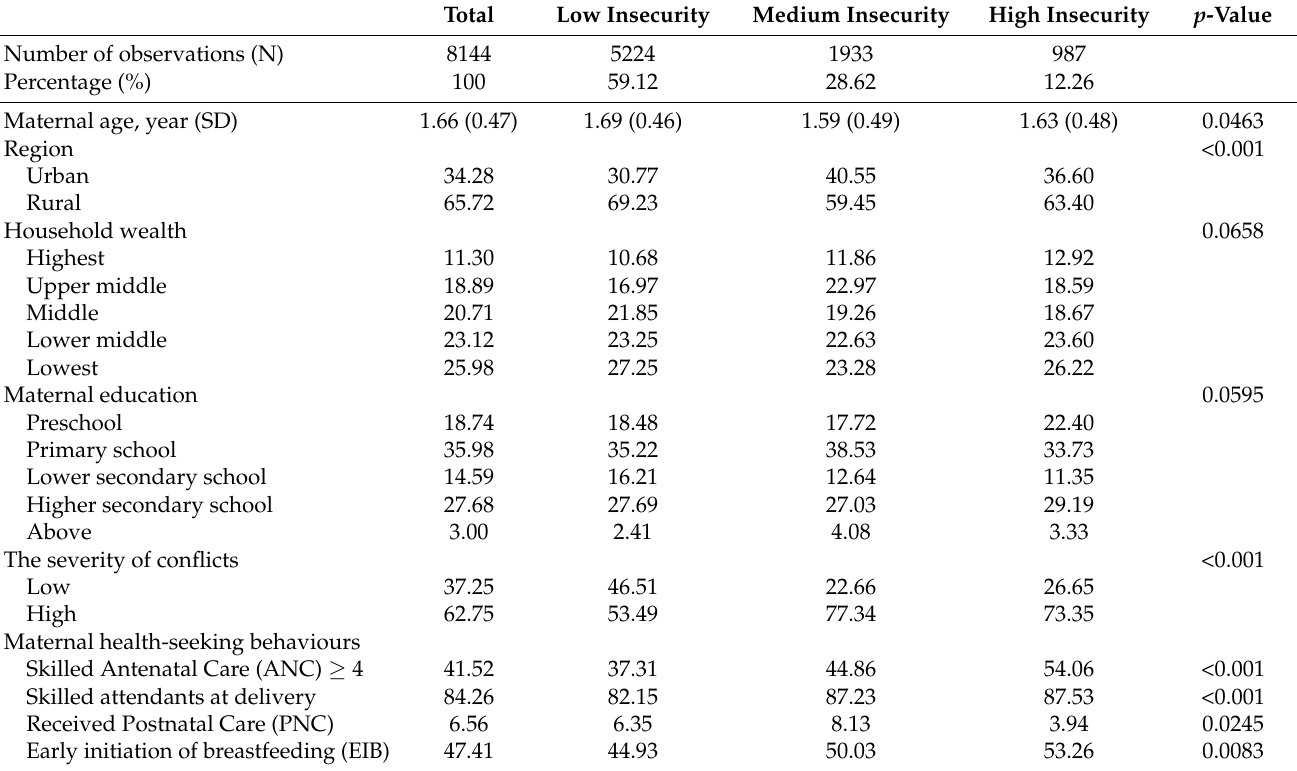
Table 2. Characteristics of females aged 15–49 with children under five †. Total Low Insecurity Medium Insecurity High Insecurity p